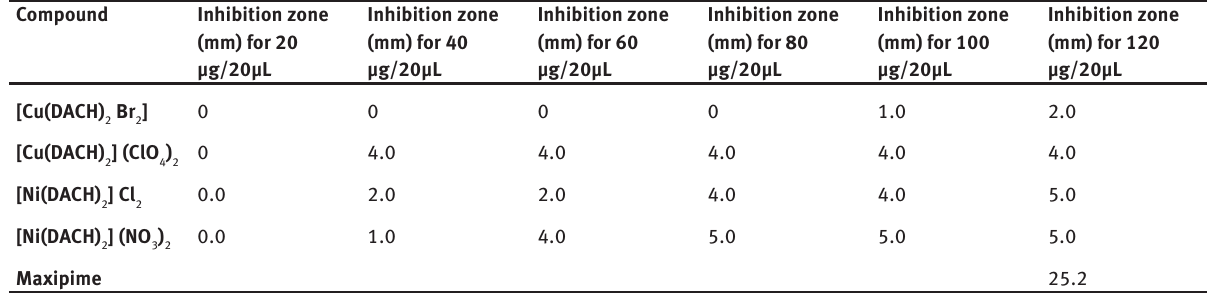
Table 6: Results of antibacterial activity of the coordination complexes of DACH against Pseudomonas aeroginosa .